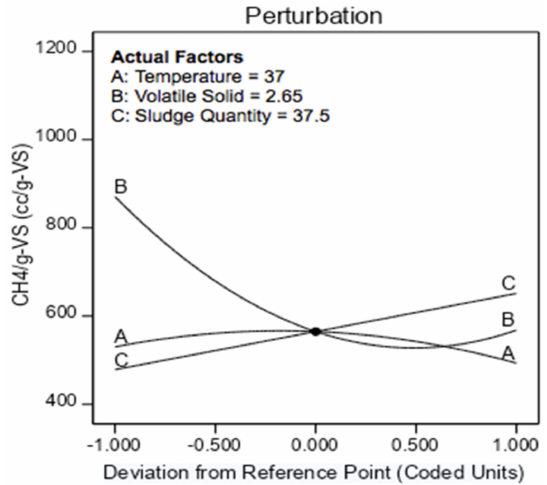
Figure 17. Perturbation plot presents the effect of all factors on CH 4 /g-VS.